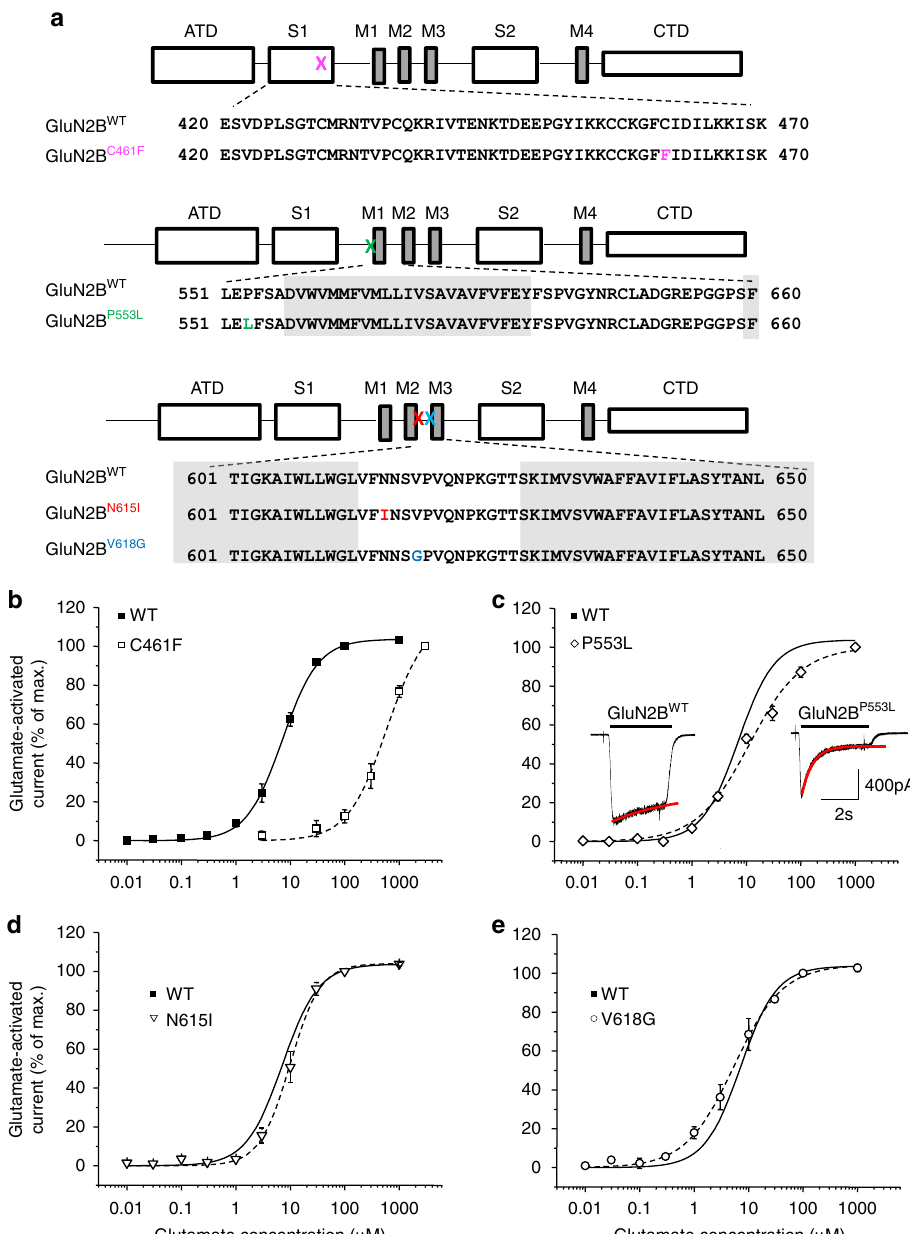
Fig. 2 Effects of GluN2B mutations on glutamate potency. a Primary sequence alignment of human NMDAR subunits showing the locations for the four selected mutations. The mutations are shown in colour in the sequence and on the linear subunit structure (crosses) showing the ATD, CTD (C-terminal domain), S1 and S2 regions, plus the M1-M4 TMD. b – e Glutamate concentration – response curves in the presence of 10 μ M glycine and normalised to the maximum peak response evoked by saturating glutamate. Control curves in c – e are taken from b . The glutamate EC 50 s and Hill slopes ( n ) are: b GluN1 – GluN2B WT 7.18 ± 0.82 μ M, 1.45 ± 0.12; GluN2B C461F 511.40 ± 55.49 μ M, 1.44 ± 0.03 unpaired Student ’ s t -test p < 0.0001, c GluN2B P553L 12.67 ± shows glutamate-activated currents (to saturating concentration of glutamate and 10 μ M glycine) in HEK293 cells expressing GluN1 – GluN2B WT or GluN1 – GluN2B P553L at − 30 mV. The red lines show exponential curve fi